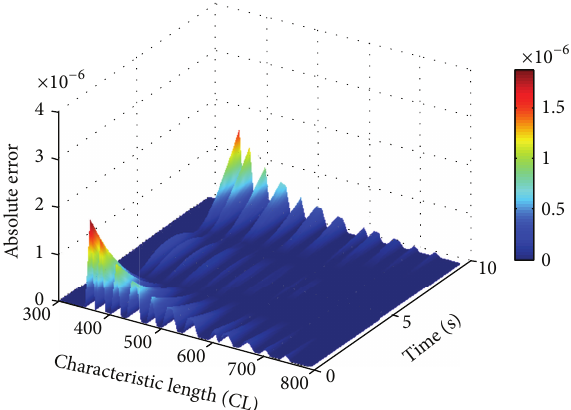
Figure 1: For Example 1, showing the error of estimation with different CLs.